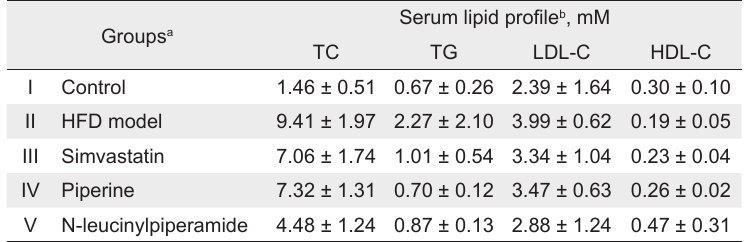
Table 1. Effect of antihyperlipidemic compounds on serum lipid content